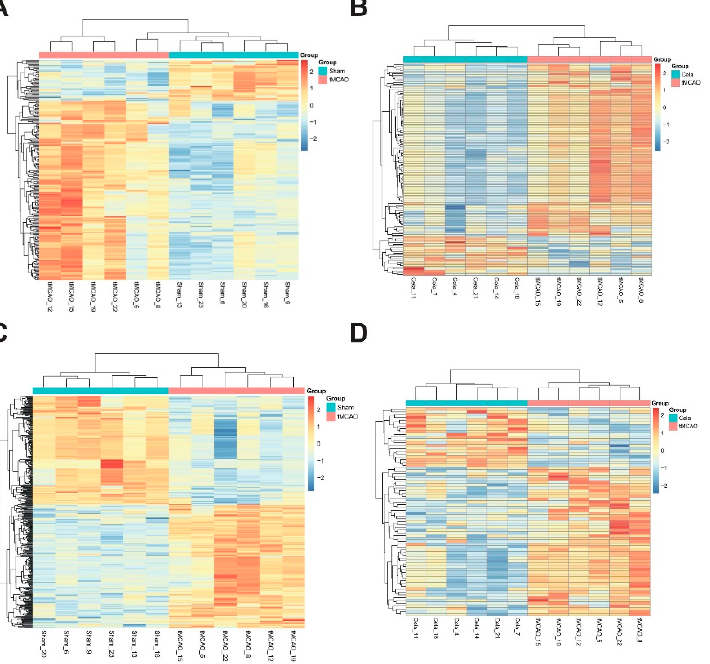
Figure 4. Heatmap of the expression of differential lipids in different comparison groups. ( A ) plasma_tMCAO/Sham, ( B ) plasma_Cela/tMCAO, ( C ) brain_tMCAO/Sham and ( D ) brain_ Cela/tMCAO